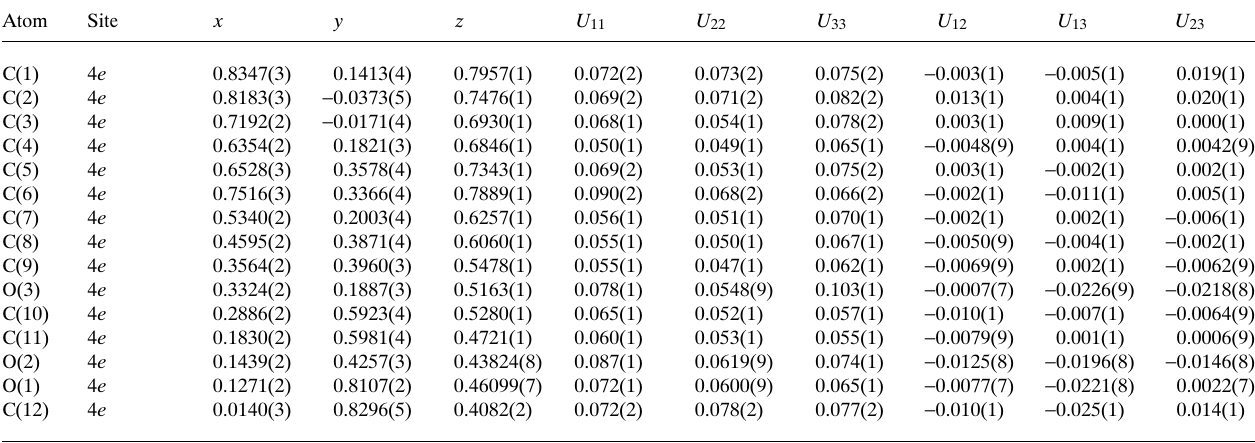
Table 3. Atomic coordinates and displacement parameters (in Å 2 )